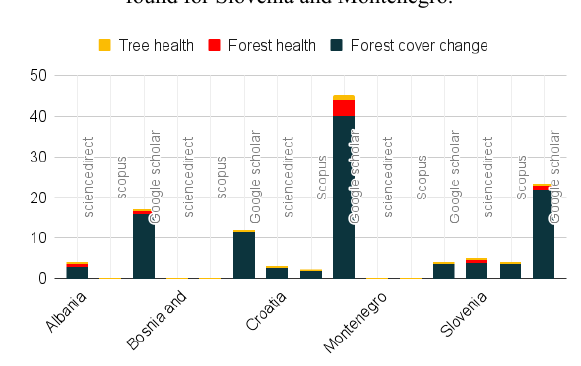
Figure 1 . The number of publications meeting inclusion criteria at Scopus and Google scholar for forest cover change, forest health and tree health per